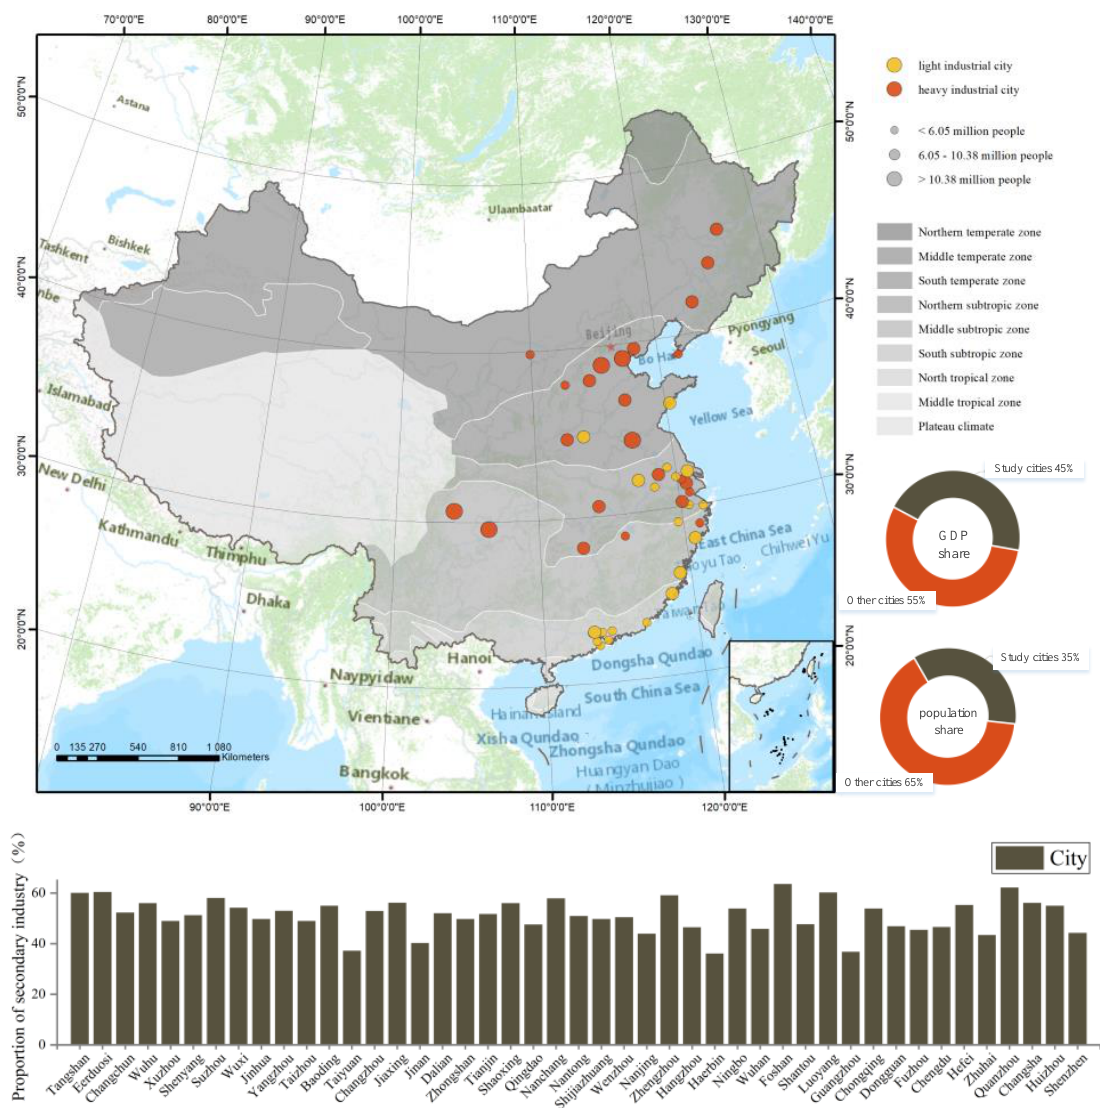
Figure 1. The study area and the fraction of secondary industry in the cities under investigation in 2019.